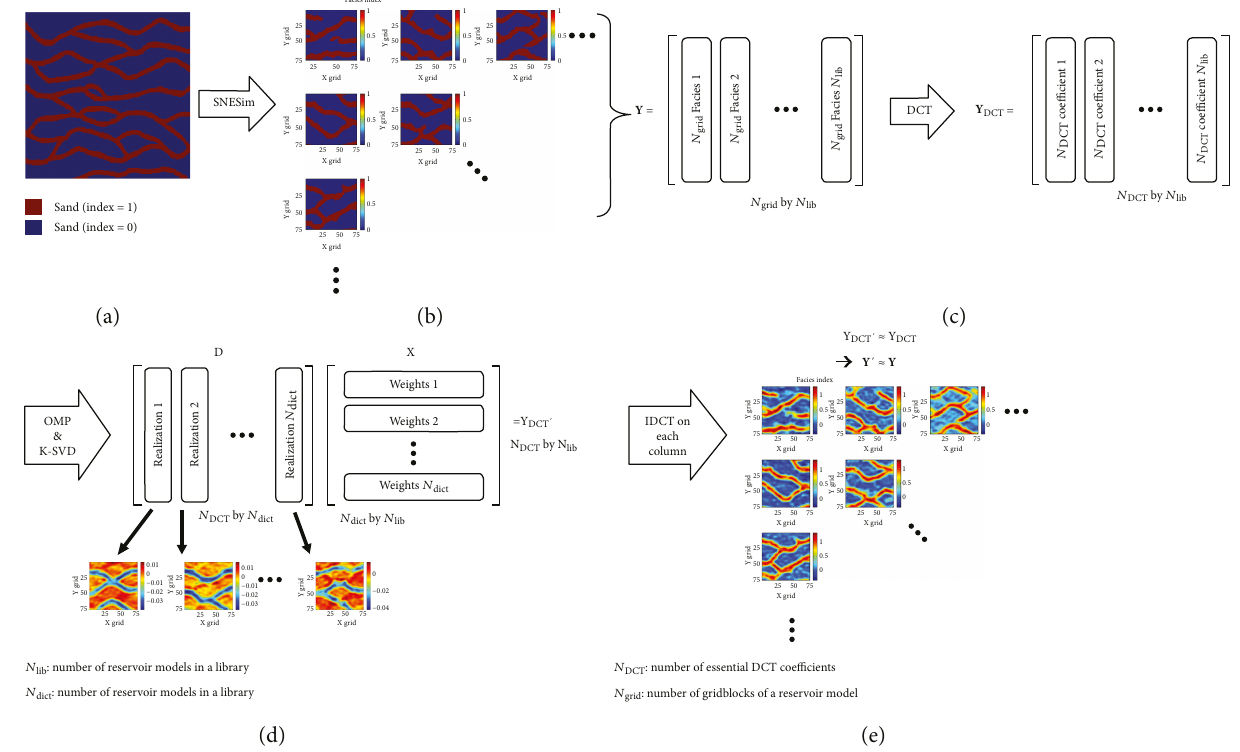
Figure 2: Construction of sparse geologic dictionaries using DCT and K-SVD: (a) training image, (b) generation of initial channel models ( Y ) using SNESim, (c) transformation of Y into DCT coe ffi cients, (d) construction of D and X from Y using K-SVD in DCT domain, and (e) reconstruction of Y from D and X